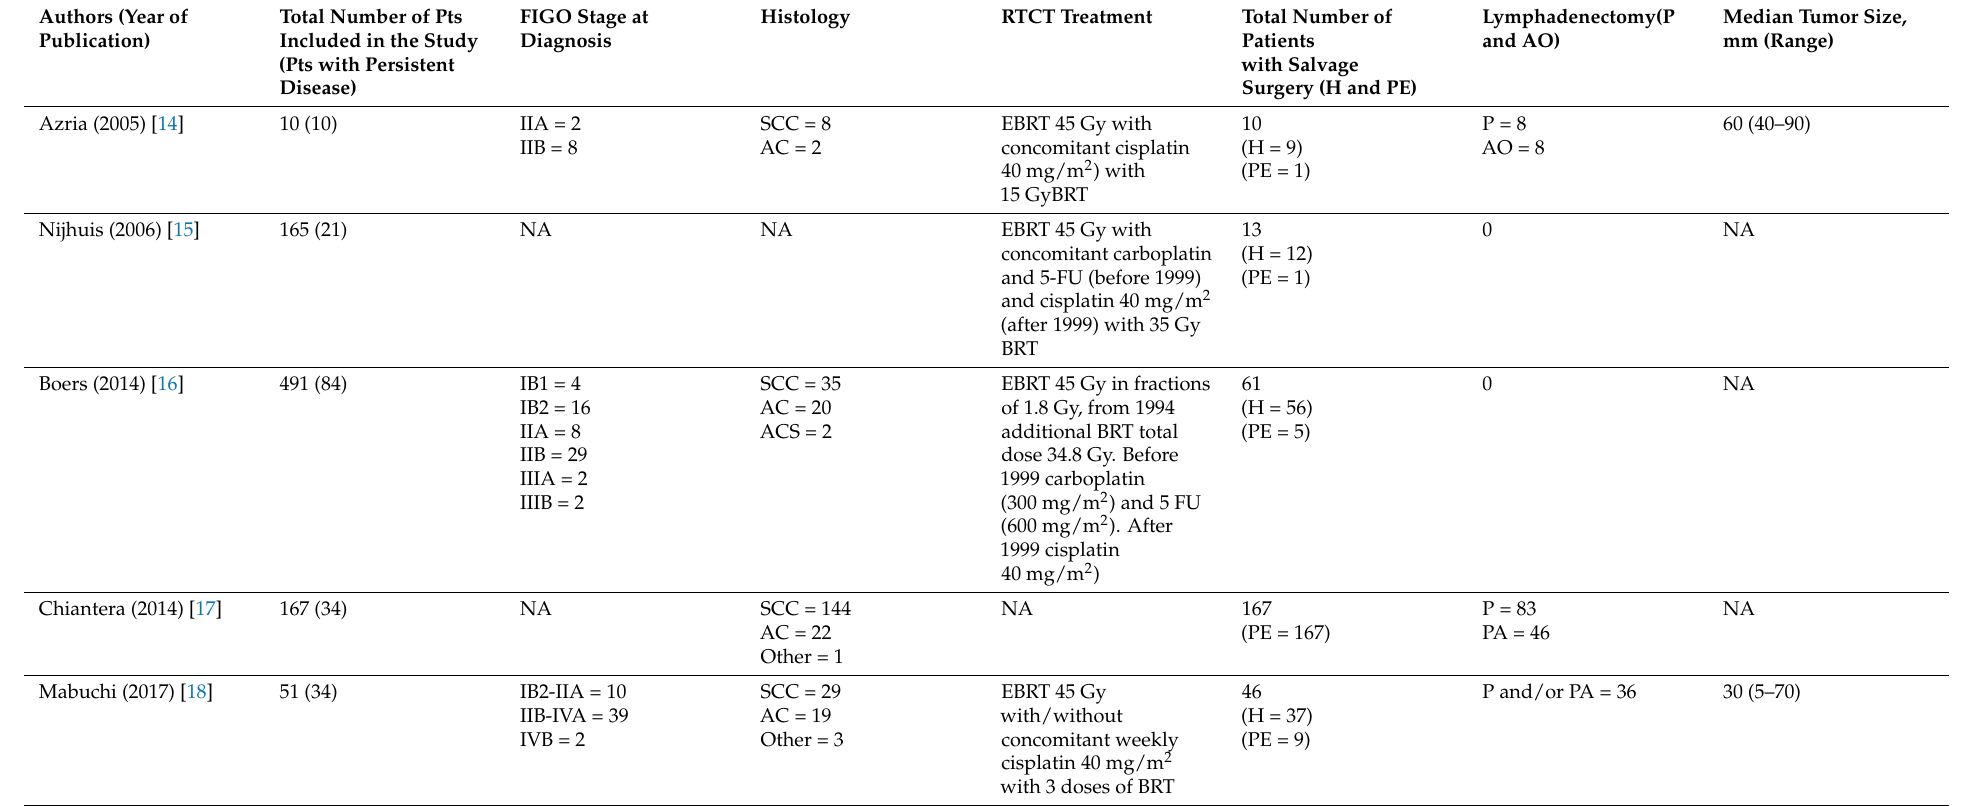
Table 2. Characteristics of studies included in the analysis